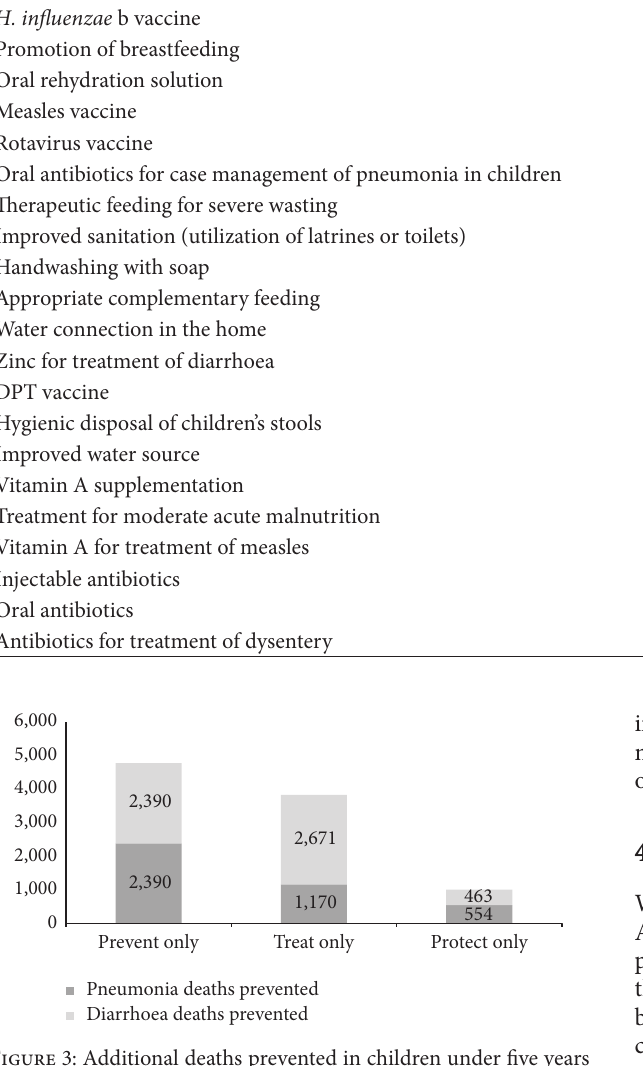
Figure 3: Additional deaths prevented in children under five years of age by cause